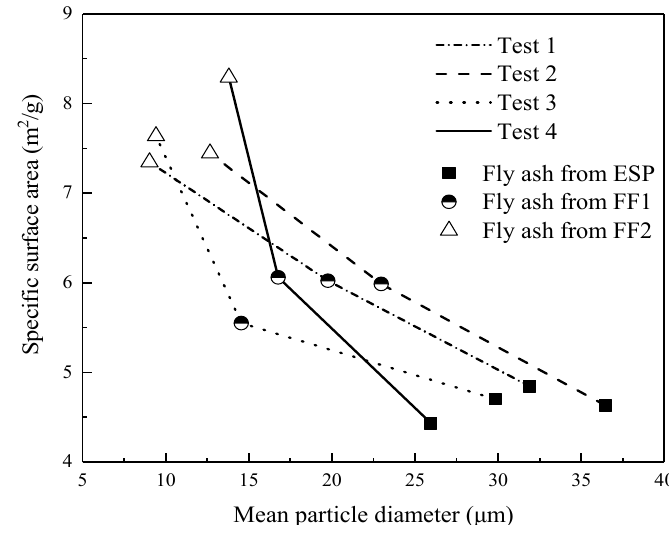
Figure 12. Specific surface area of the fly ash samples collected from the ESP, FF1 and FF2.